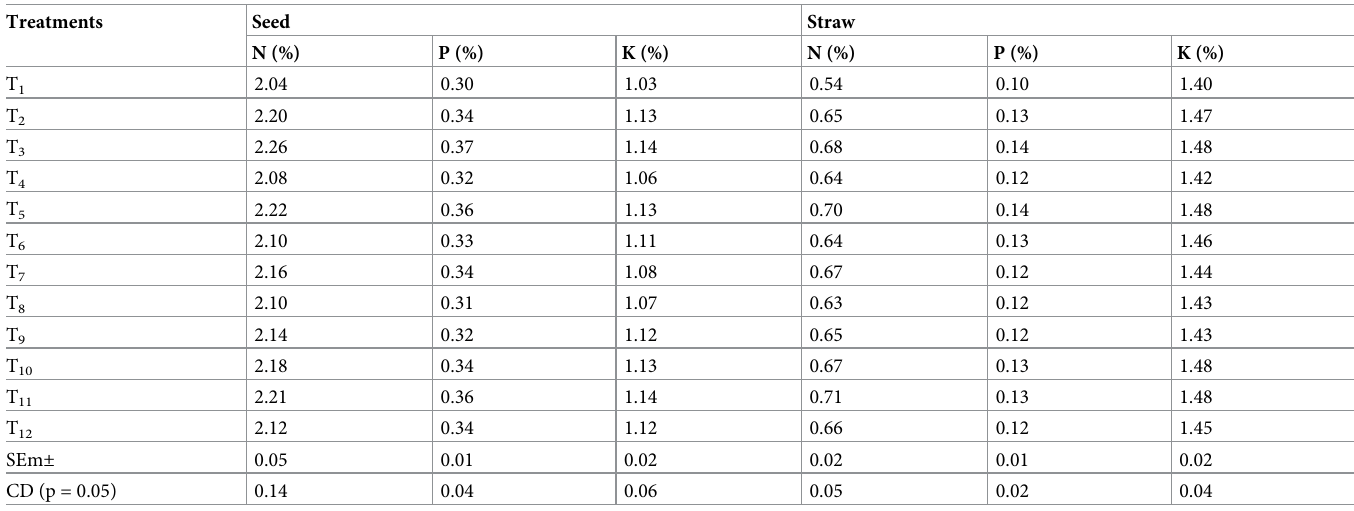
Table 4. Nutrient concentration in chickpea under various INM modules.